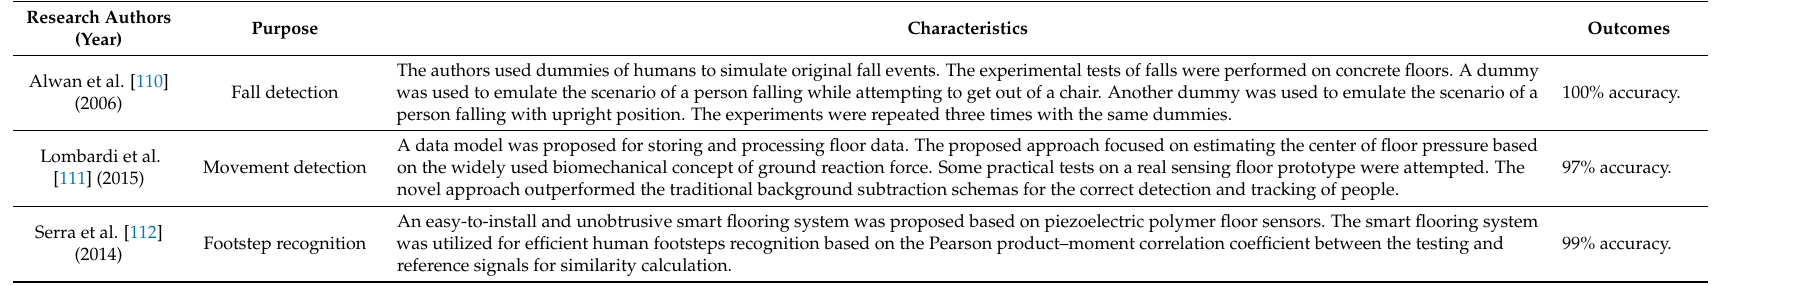
Table 6. Summary of research works that use floor sensor technology.